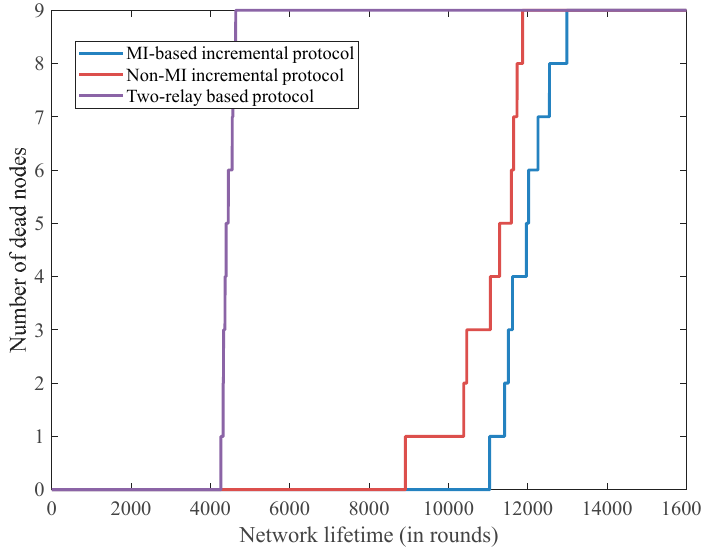
Figure 4. The number of dead implanted sensors versus network lifetime.